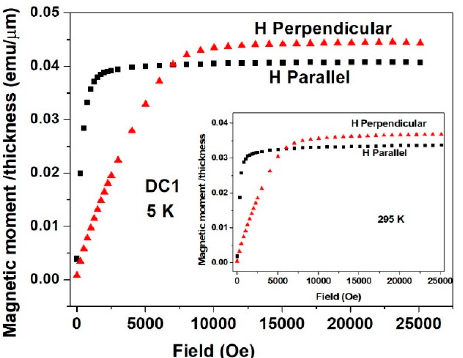
Figure 10. Isothermal magnetic moment plots measured at 5 and 295 K (inset) parallel (black symbols) and perpendicular (red symbols) to the plane of DC1 deposited quaternary Sn-Fe-Ni-Co alloy coatings. The moment values are in emu/ μ m (see text).